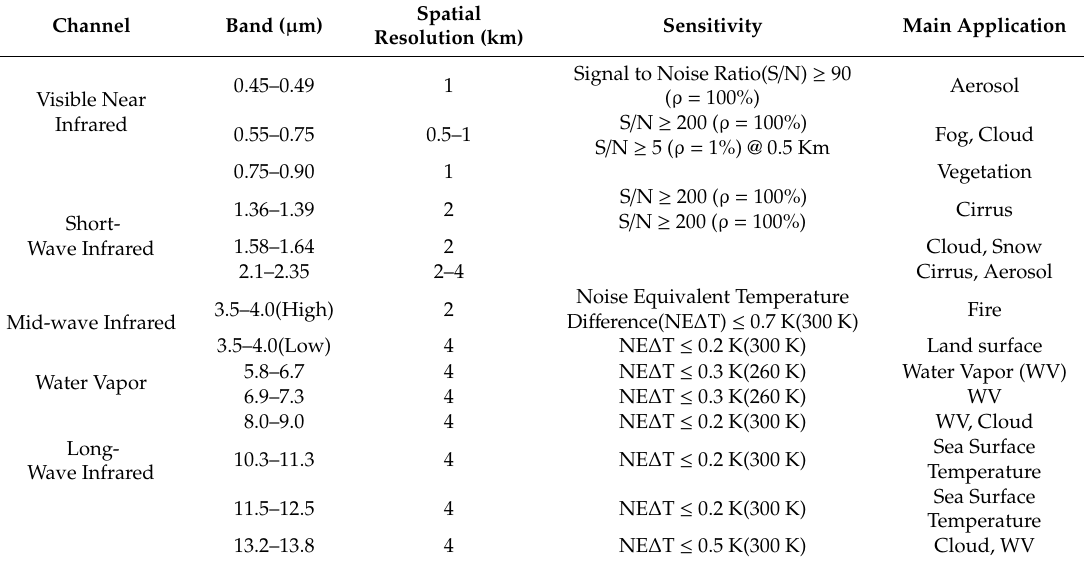
Table 1. Performance of AGRI onboard FY-4A.